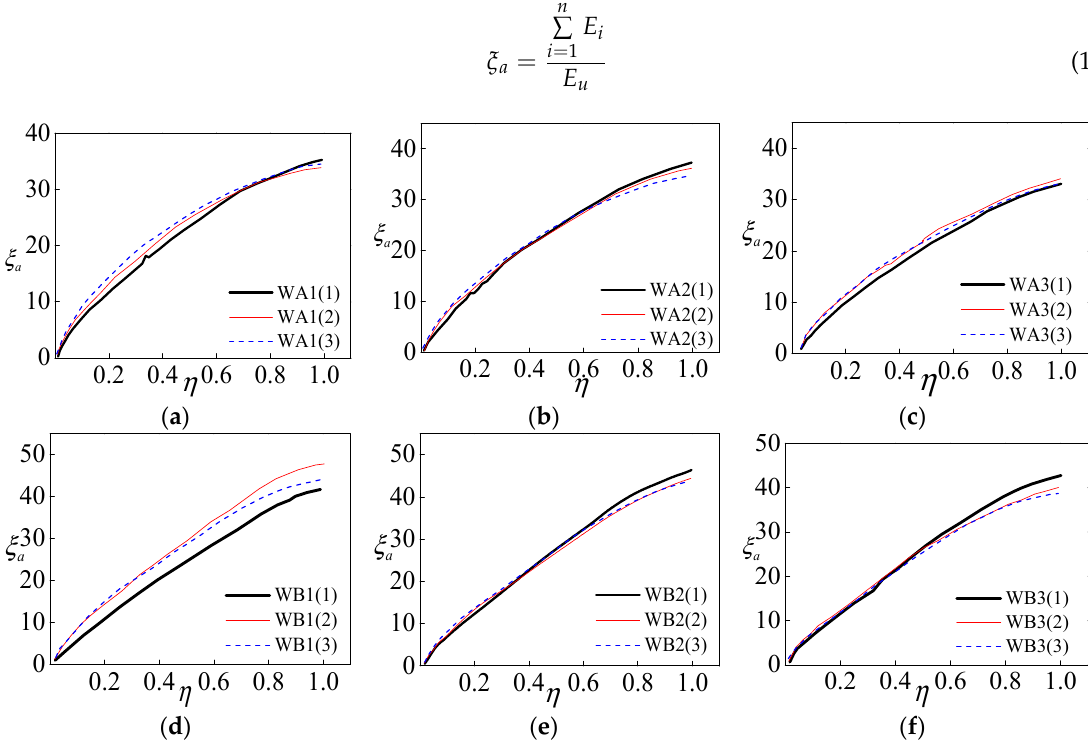
Figure 9. ξ a - η curve of welding material. ( a ) WA1 ξ a - η ; ( b ) WA2 ξ a - η ; ( c ) WA3 ξ a - η ; ( d ) WB1 ξ a - η ; ( e ) WA2 ξ a - η ; ( f ) WA3 ξ a - η .